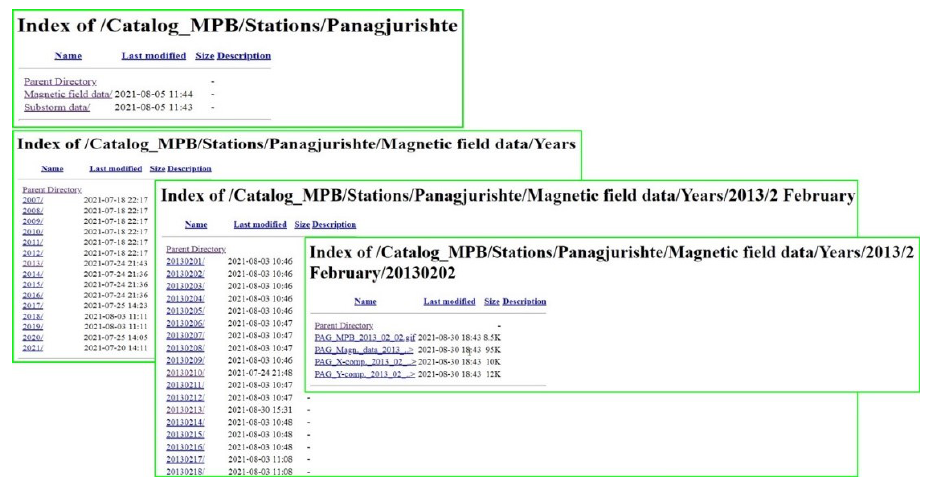
Fig. 7. Consecutive windows to look at the graphics for a given